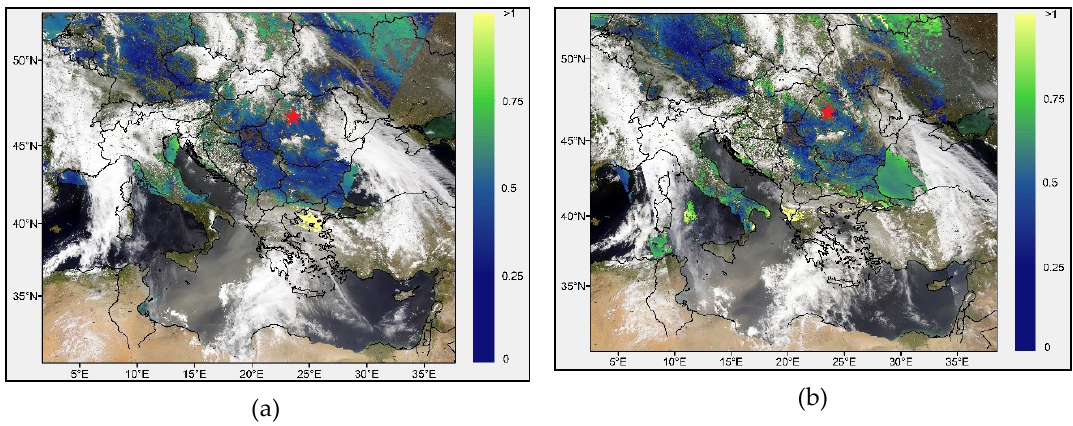
Figure 4. AOD MODIS Terra ( a ) and Aqua ( b ) for April the 24th 2019.